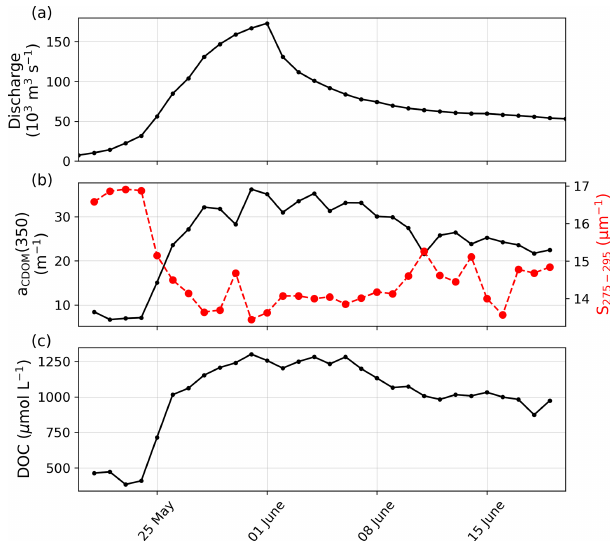
Figure 3. (a) Corrected daily Lena River discharge data, (b) a CDOM (350) and S 275 − 295 , and (c) DOC concentration mea- sured near Samoylov Island in the Lena Delta during the spring freshet in May/June